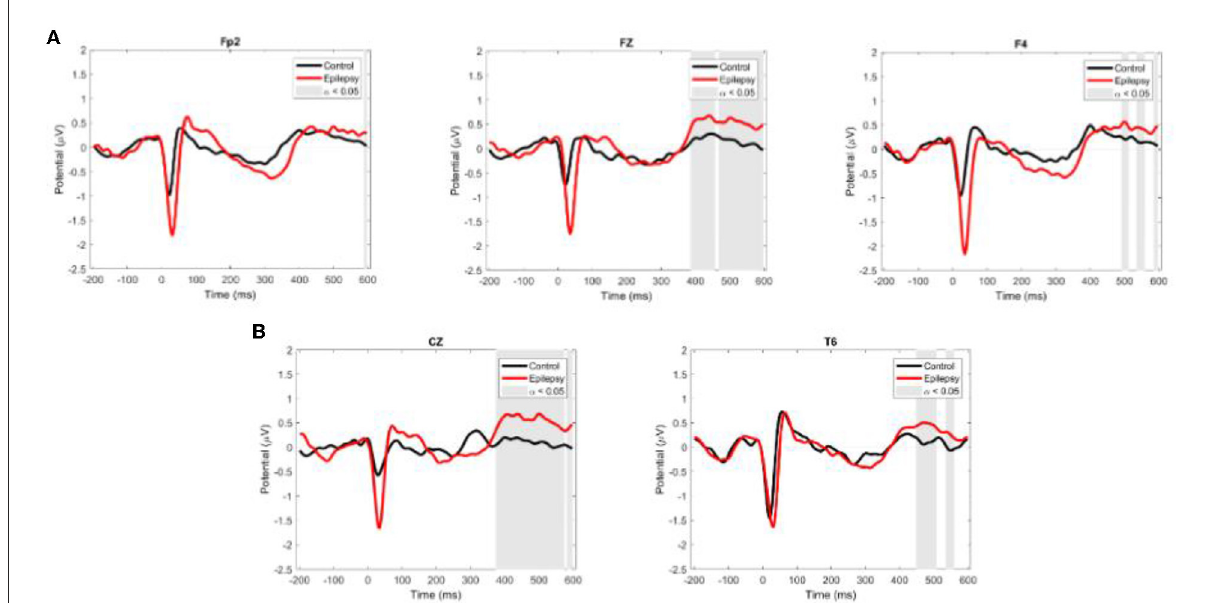
FIGURE4 Grand average ERP waveforms for EEG channels with intergroup differences. (A) Channels where HEP amplitude is higher in the RE than in the control group. (B) Channels where HEP amplitude is higher in the control than in the RE group. Red and black lines are ER and control values, respectively. Shaded areas show the time-windows where there was a significant difference between groups (ANOVA, a =